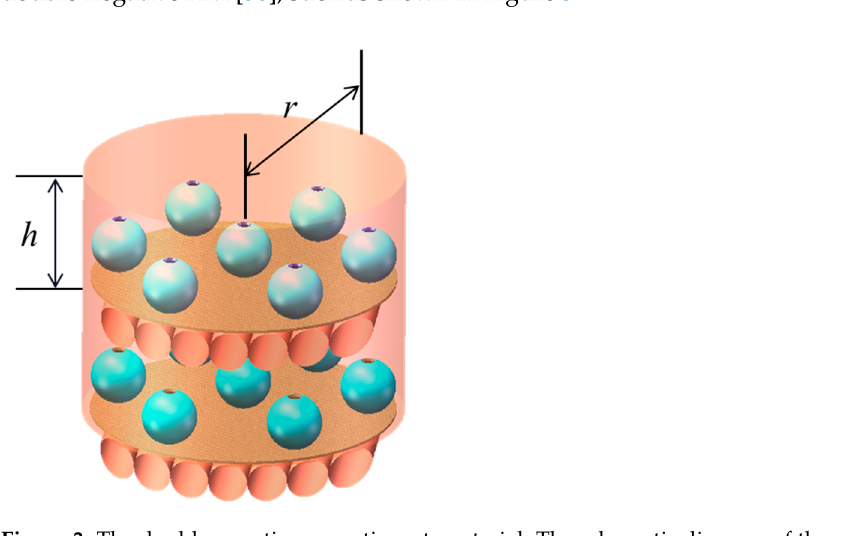
Figure 2. The unit cell of hollow steel tube (HT) structure.